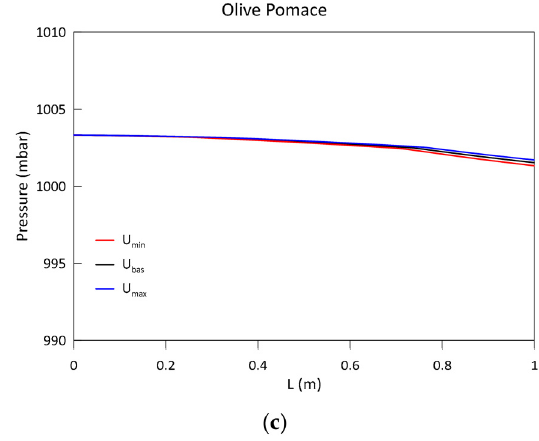
Figure 18. Pressure evolution along the reactor axis at different biomass/residual material initial moisture content levels for